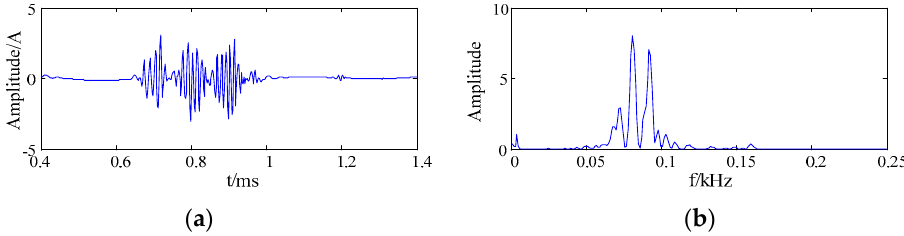
Figure 8. The waveform and spectrum after noise reduction based on EMD and wavelet packet ( a ) the waveform; ( b ) the frequency spectrum.